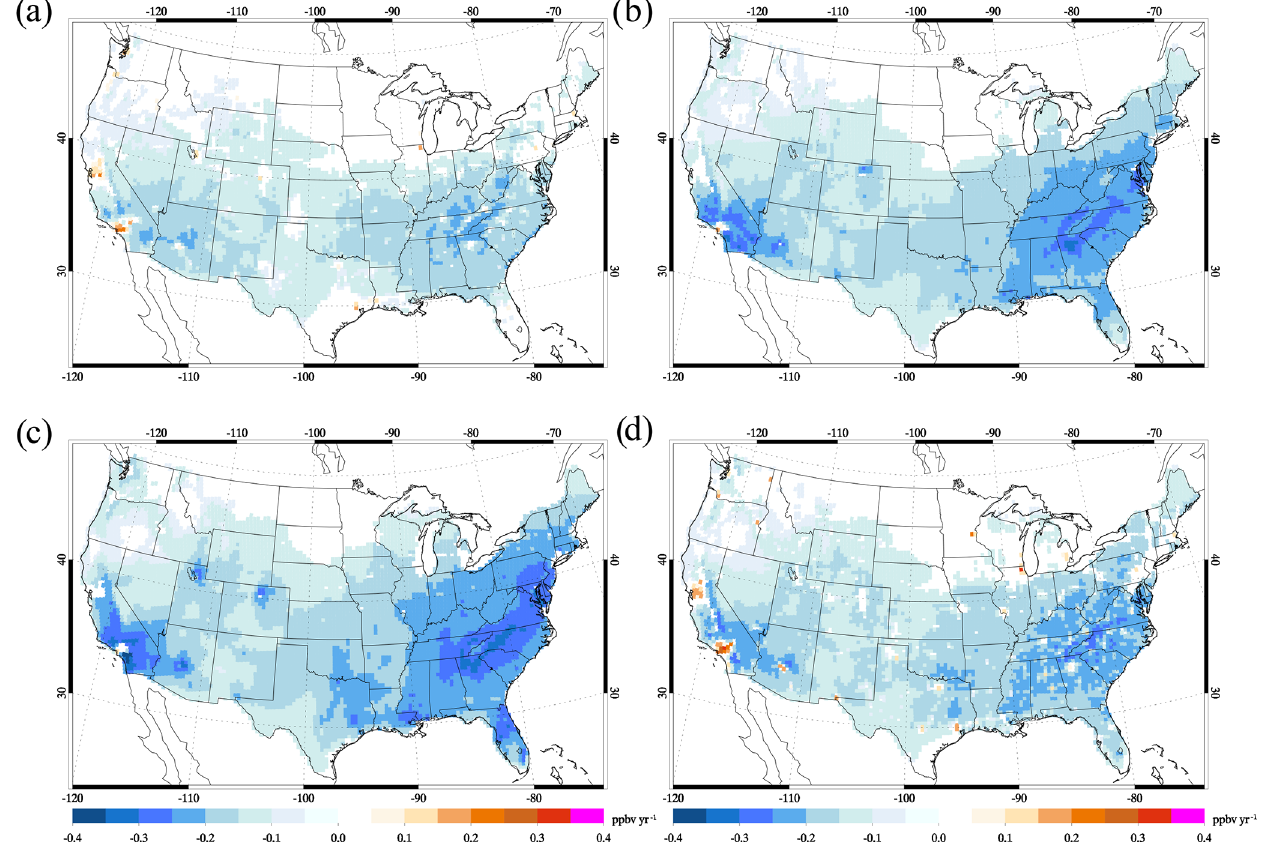
Figure 8. Trends in ozone simulations from CMAQ during 1990-2015 (in parts per billion by volume per year) at (a) 08:00LT, (b) 12:00LT, (c) 16:00LT and (d) 20:00LT. We only show CMAQ grids with a statistically significant linear trend in the